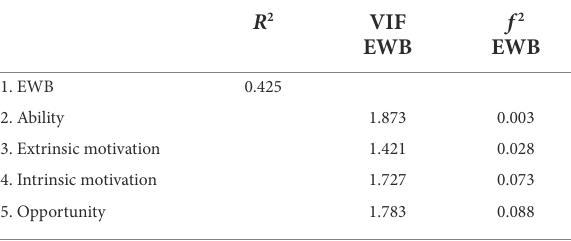
TABLE 5 Coefficient of determination (R 2 ), collinearity assessment (VIF) and effect size (f 2